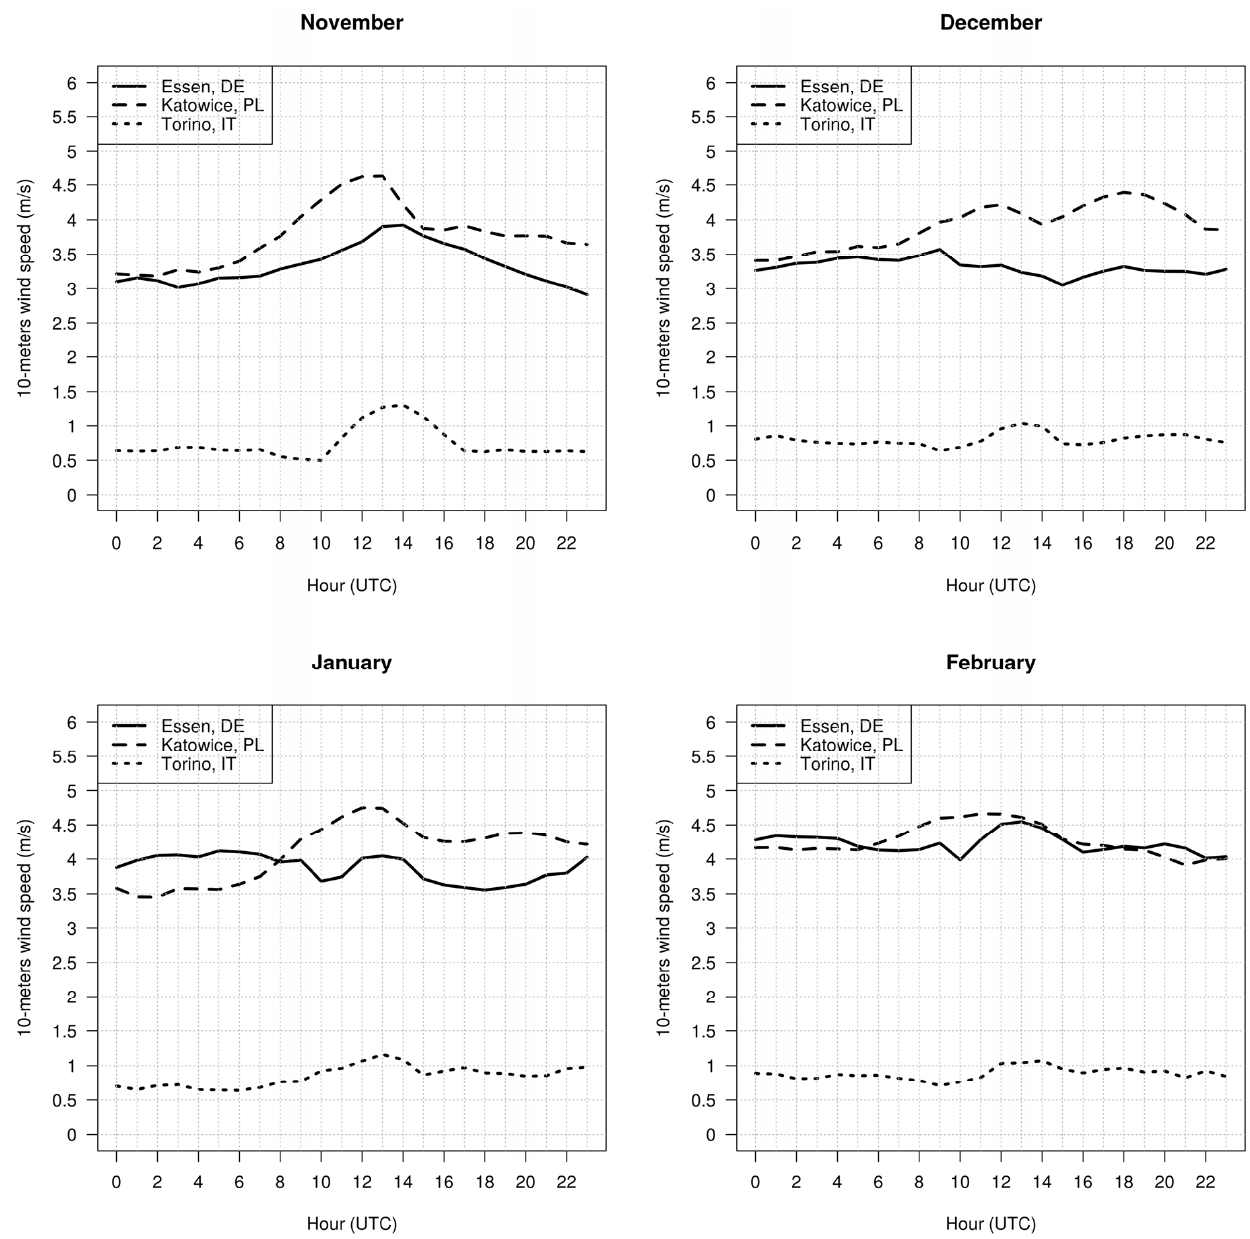
Figure 5. Wind speed diurnal pattern in Torino (North-Western Italy), Essen (North-Western Germany) and Katowice (Southern Poland) during the cold season (average values from 1979 to 2020).